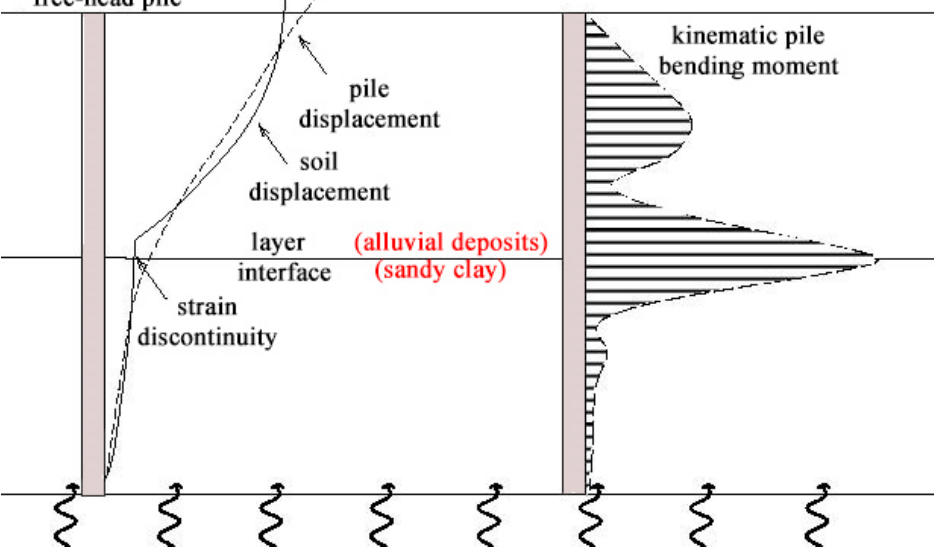
Figure 31. Kinematic bending of a free-head pile in a two-layer profile (After Castelli et al. [12], modified).